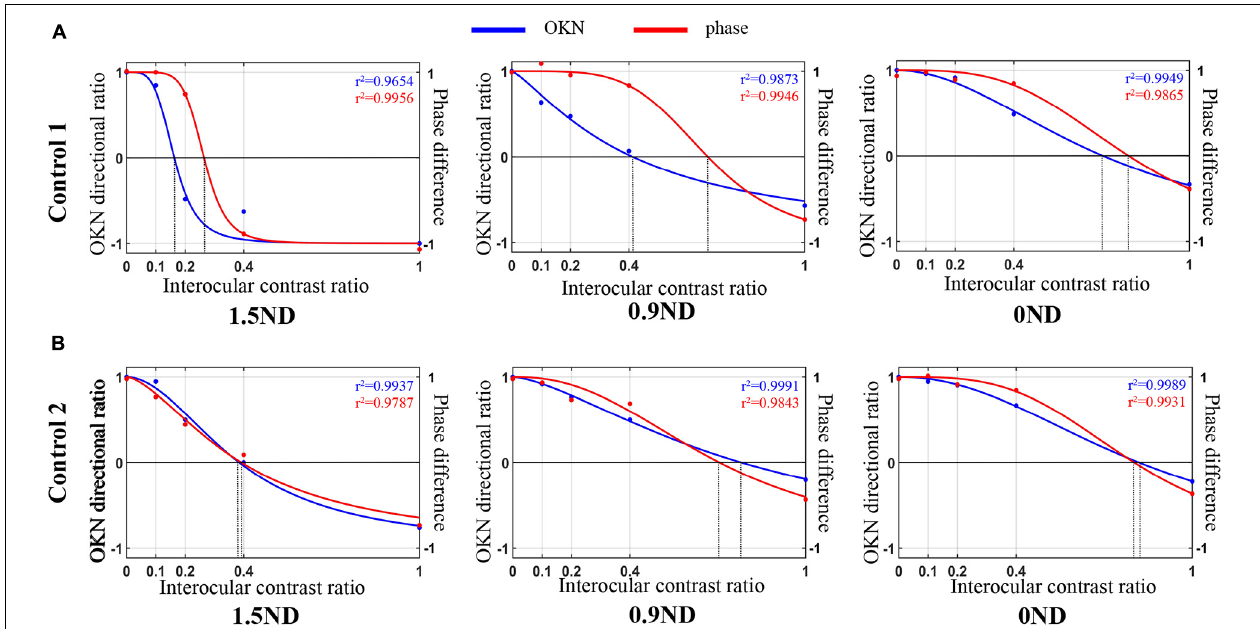
FIGURE 4 | Comparison of the dOKN test and phase tests in control subjects. (A) Control 1. (B) Control 2. The fitting curves of two healthy controls’ curve fittings obtained from the dOKN test (blue line) and the phase method (red line). The x -axis represents the grating contrast ratio (dominant/non-dominant), and the y -axis represents the OKN directional ratio or the phase